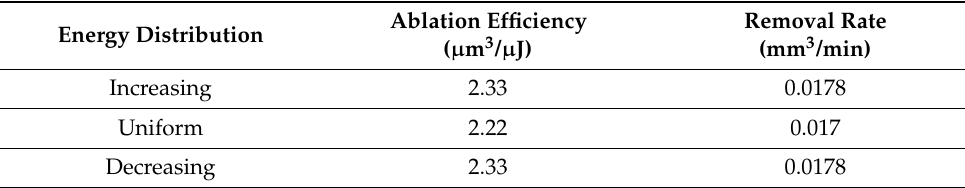
Table A6. Ablation efficiencies and removal rates of titanium.